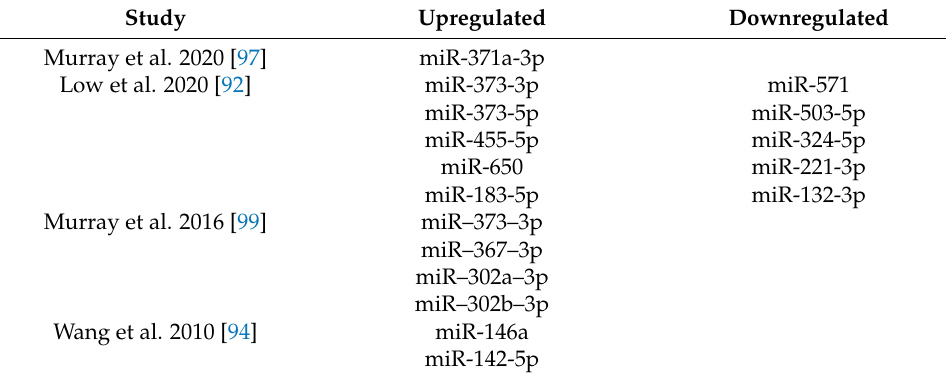
Table 6. Up and downregulation of miRNAs in GCT.